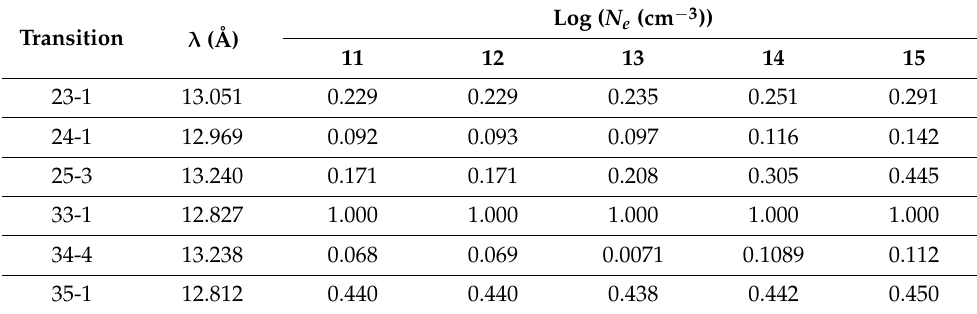
Table 14. Intensity ratios of the X-ray lines from Fe